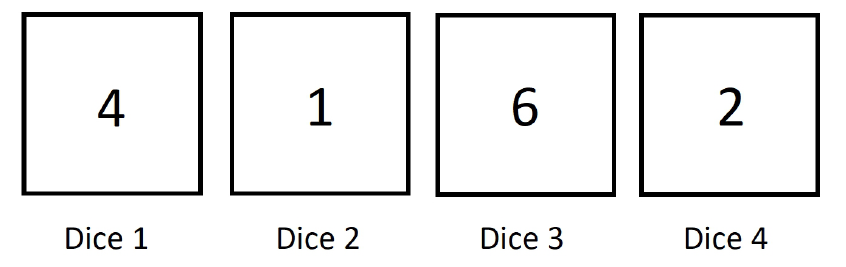
Figure 4. 421World winning